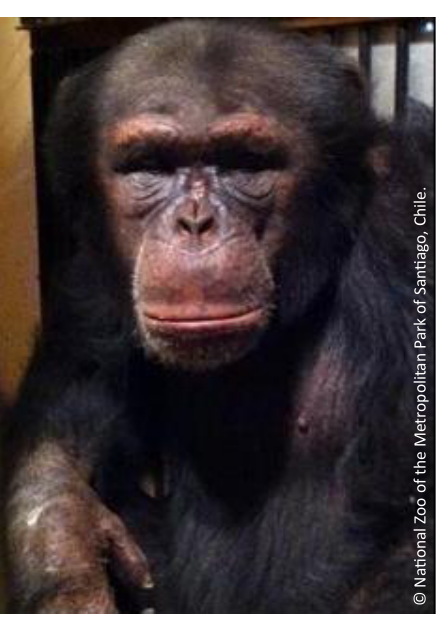
Image 3. Specimen 2- Pan troglod ytes verus